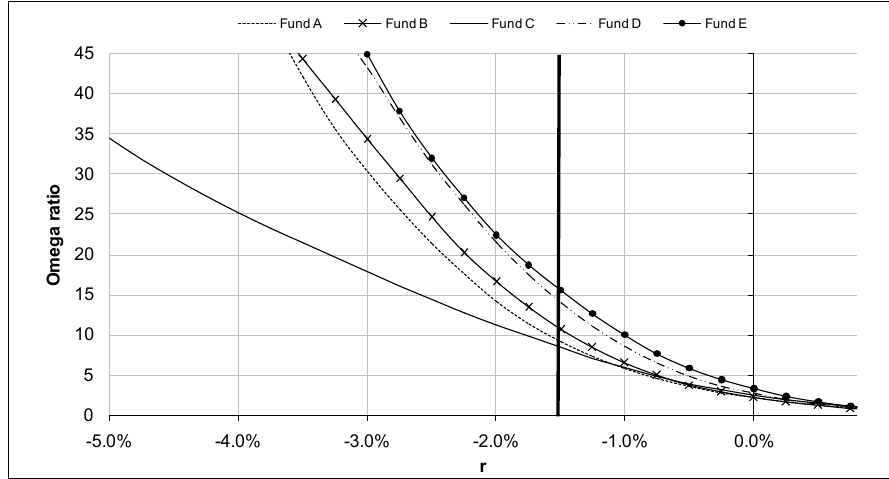
FIGURE 3: Omega at threshold = -2% Source: Authors